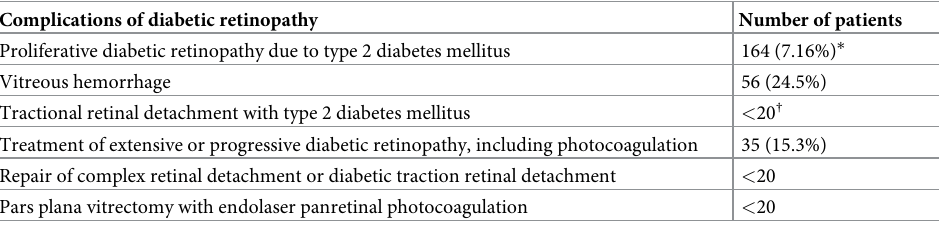
Table 2. Distribution of patients with complications of diabetic retinopathy (n = 229). Complications of diabetic